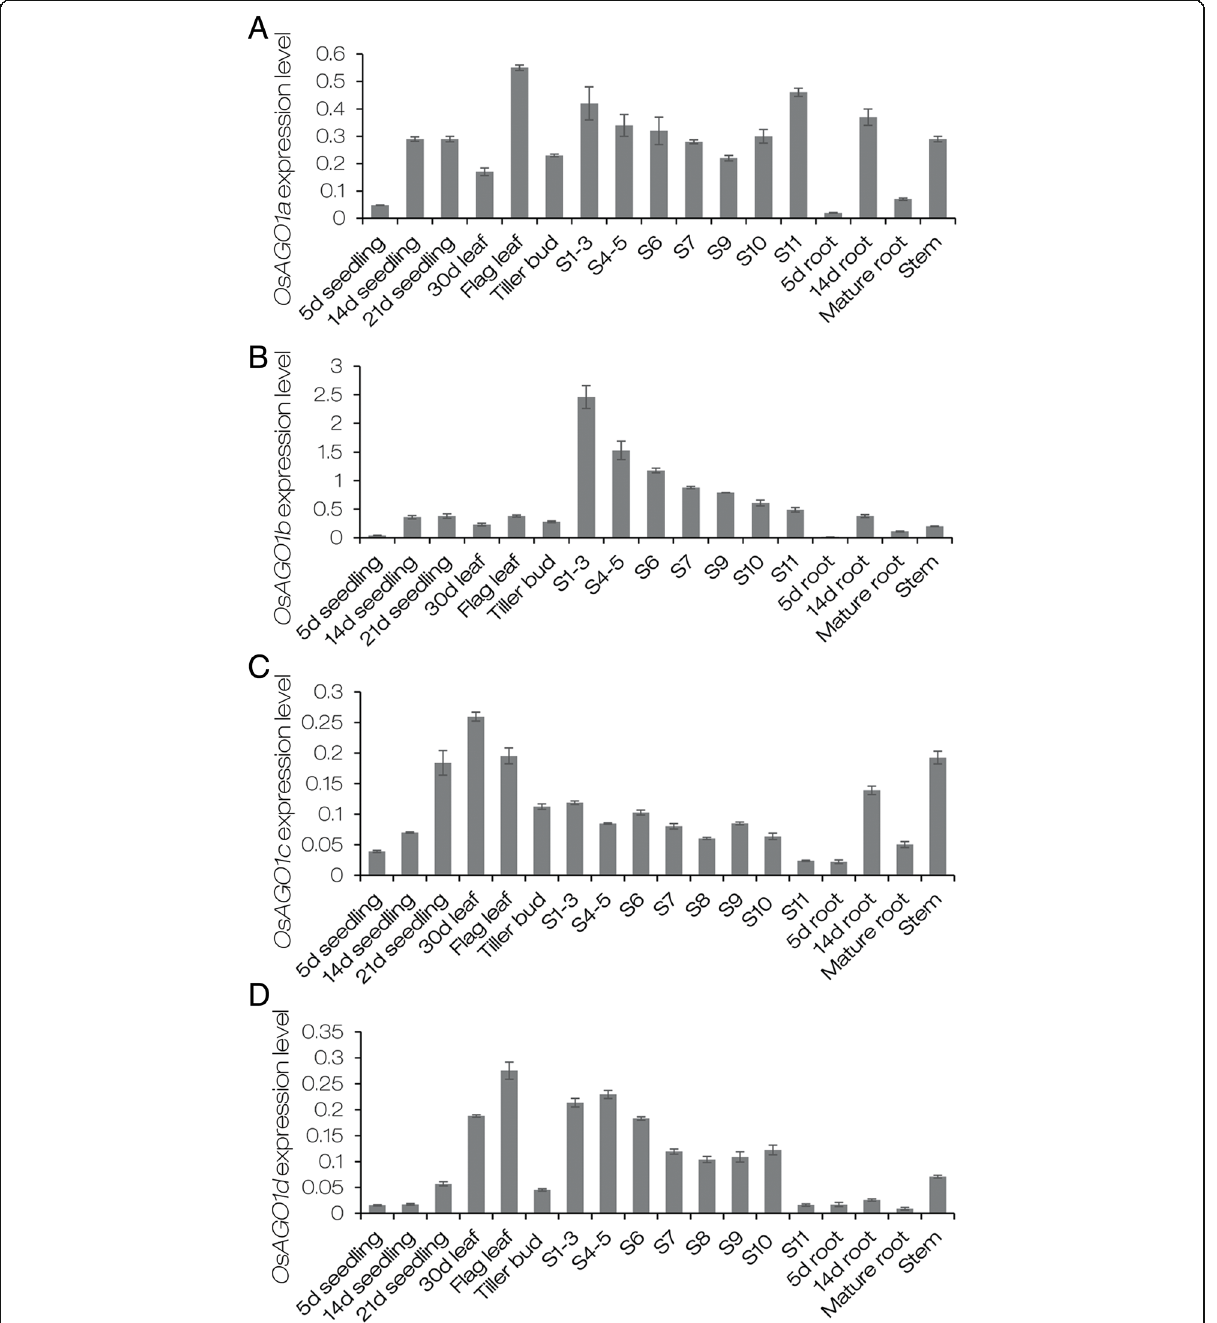
Fig. 5 Expression patterns of four rice AGO1 genes. a - d Relative expression levels of OsAGO1a , OsAGO1b , OsAGO1c and OsAGO1d in various tissues from ZH11 at different developmental stages. 5 d seedlings, 14 d seedlings and 21 d seedlings were harvested from 5-day-old, 14-day-old and 21-day-old seedlings respectively. 30 d leaves indicated the fourth leaves of 30-day-old seedlings. Flag leaves were harvested at the heading stage. S1-S11 indicates spikelets at different developmental stages (Zhang and Wilson 2009). 5 d roots, 14 d roots and mature roots were harvested from 5-day-old, 14-day-old seedlings and heading-stage plants, respectively. Stem tissues were harvested from the third internode of heading-stage plants. The OsActin1 (XM_015774830) was used as the internal standard to normalize the expression levels of detected genes. Error bars represent standard deviations among replicates ( n =